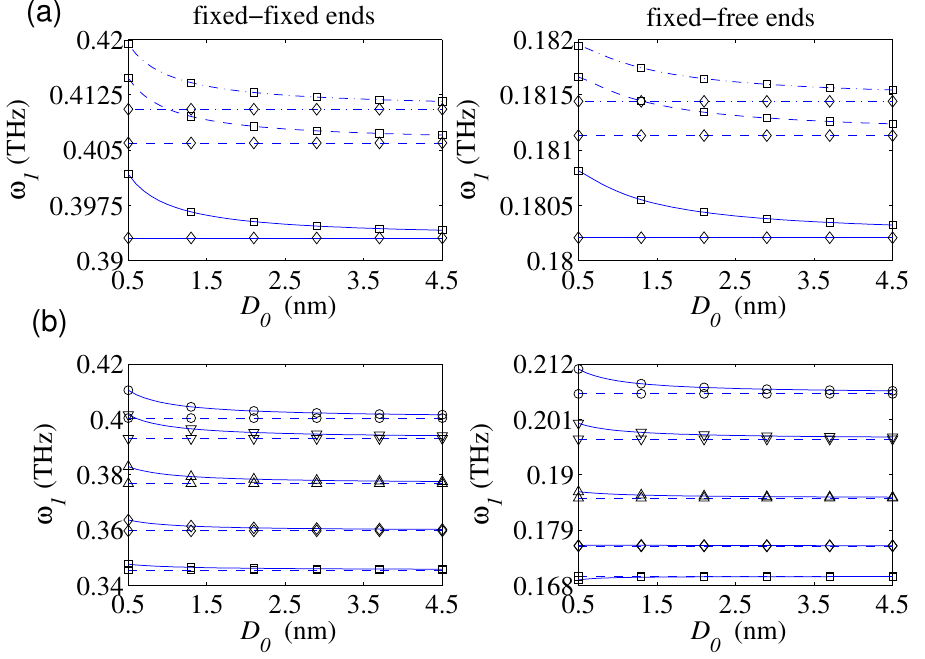
Figure 4. The fundamental frequency as a function of the defected nanorod’s diameter with and without considering the surface effect for: ( a ) different values of e 0 a ; (( − . − ) e 0 a = 0, ( −− ) e 0 a = 1